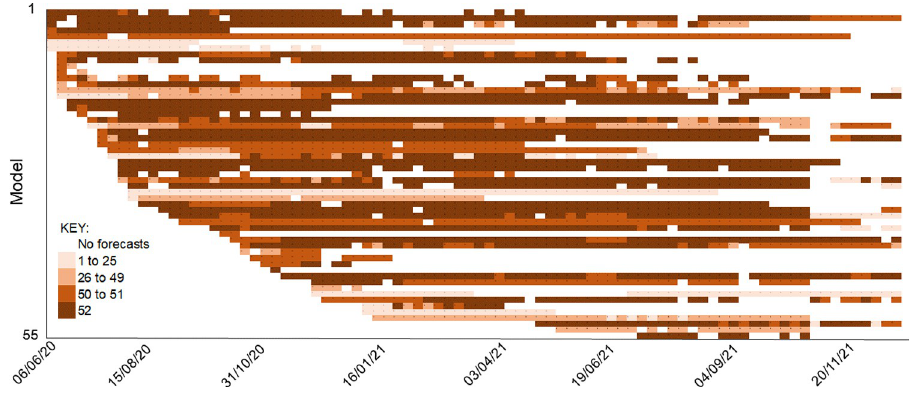
Fig 2. Data availability for forecasts of incident COVID-19